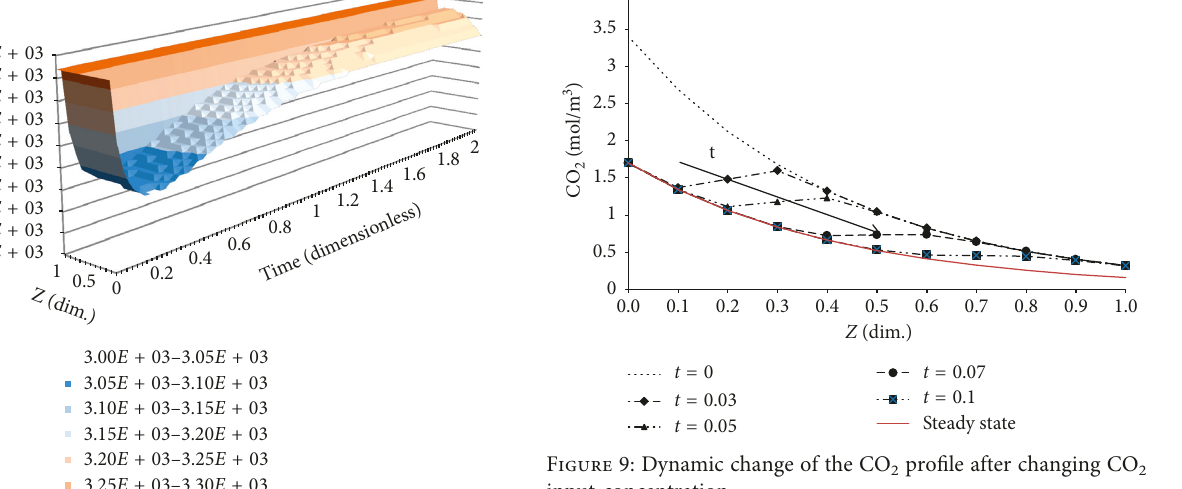
2 profile after changing CO 2